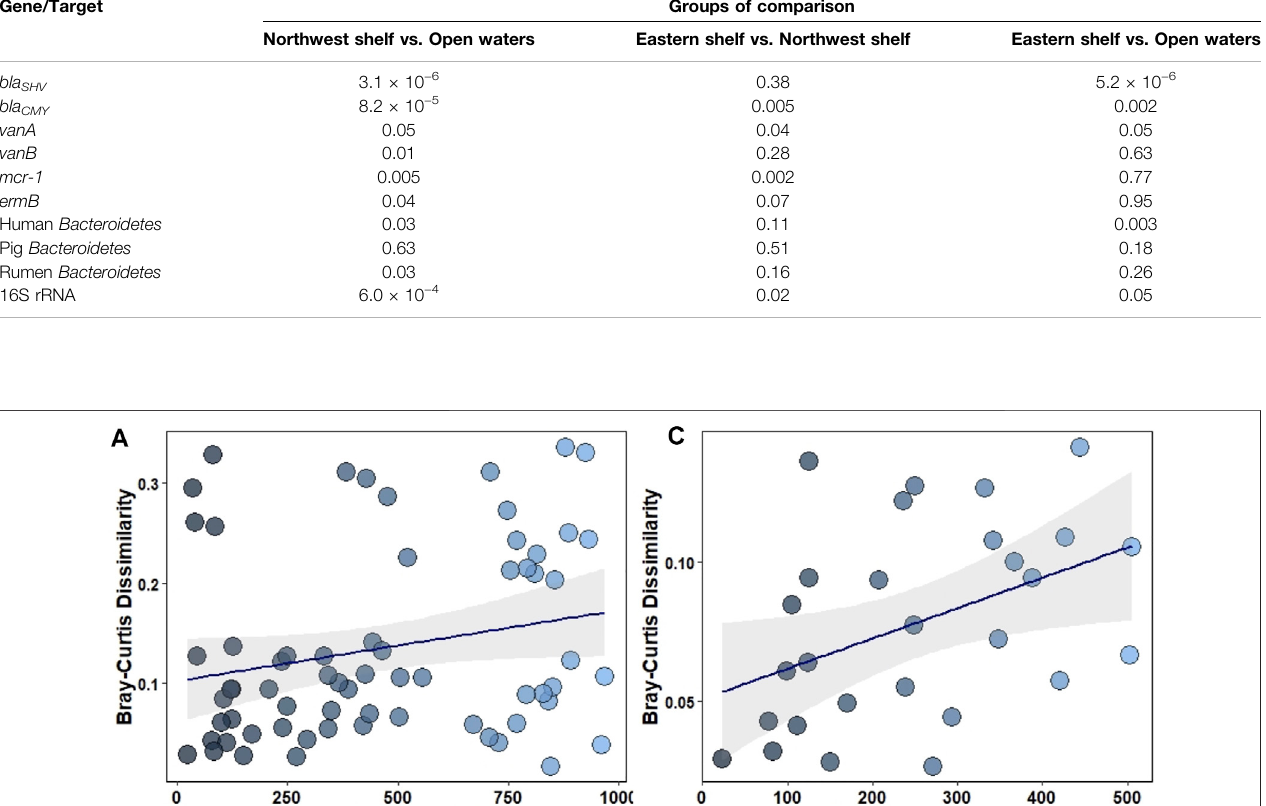
TABLE 2 | Wilcoxon rank sum test comparison of the AGS ’ absolute number in eastern shelf, open waters, northwest shelf. p -value adjustment method: fdr (q-value < 0.05). Gene/Target